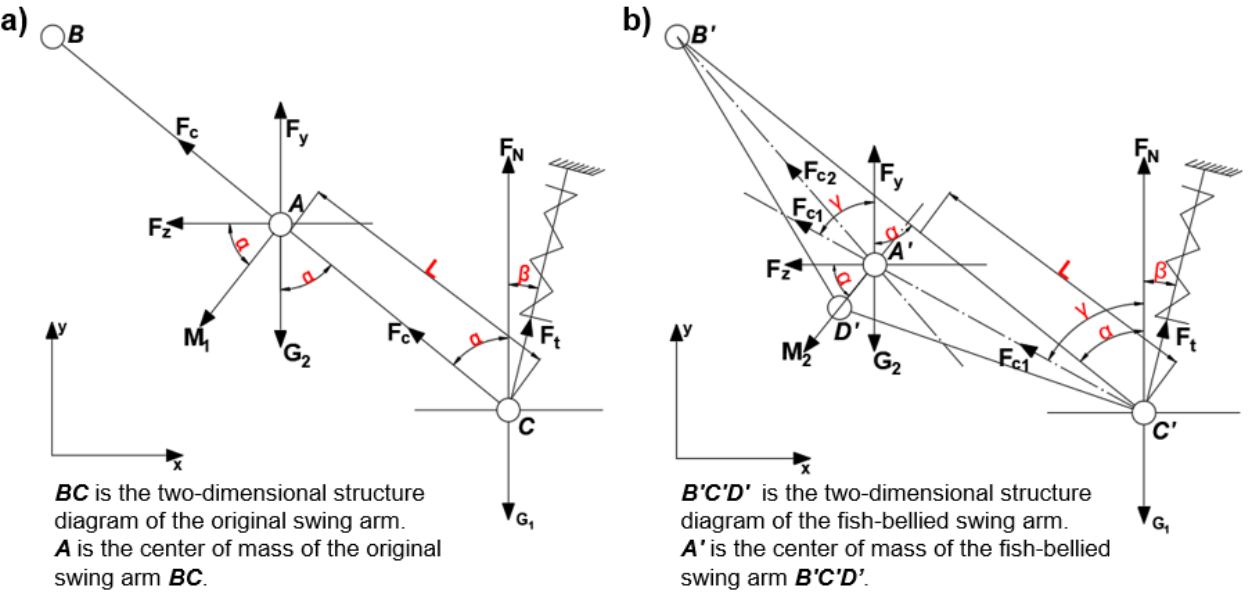
Figure 2. ( a ) The centroid force analysis diagram of the original pendulum arm; ( b ) the centroid force analysis diagram of the present pendulum